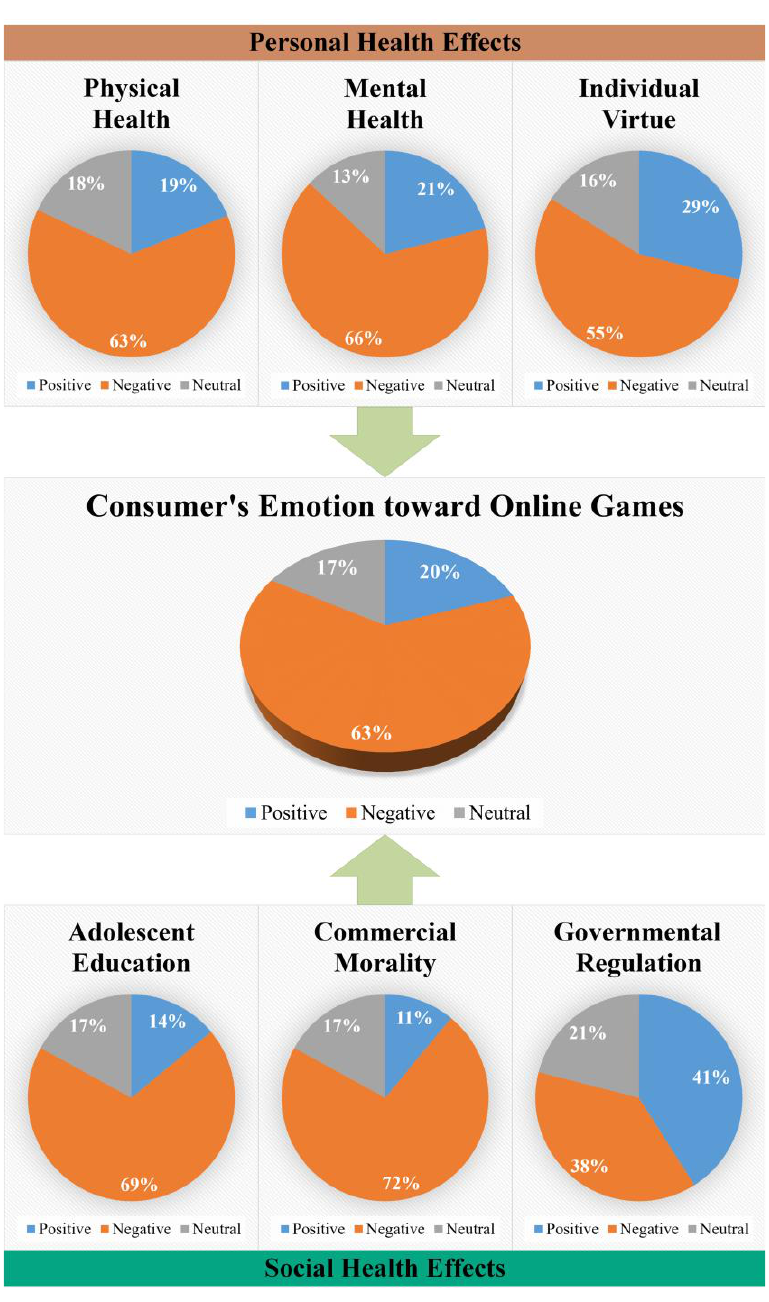
Figure 5. Emotion pie graph of c onsumers’ opinions on online games.